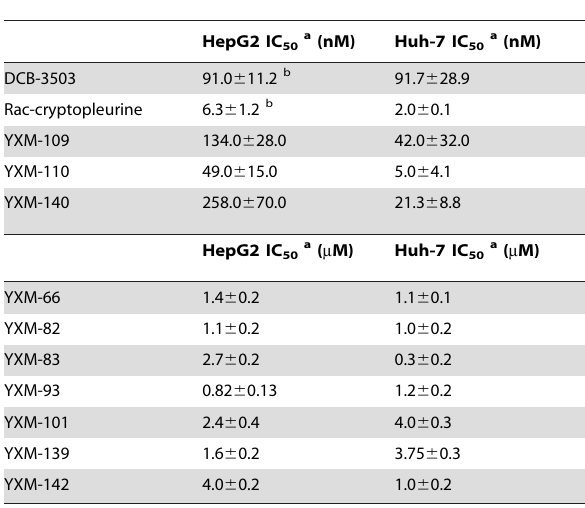
Table 1. The IC 50 of tylophora alkaloids analogs on the growth inhibition of HepG2 and Huh 7